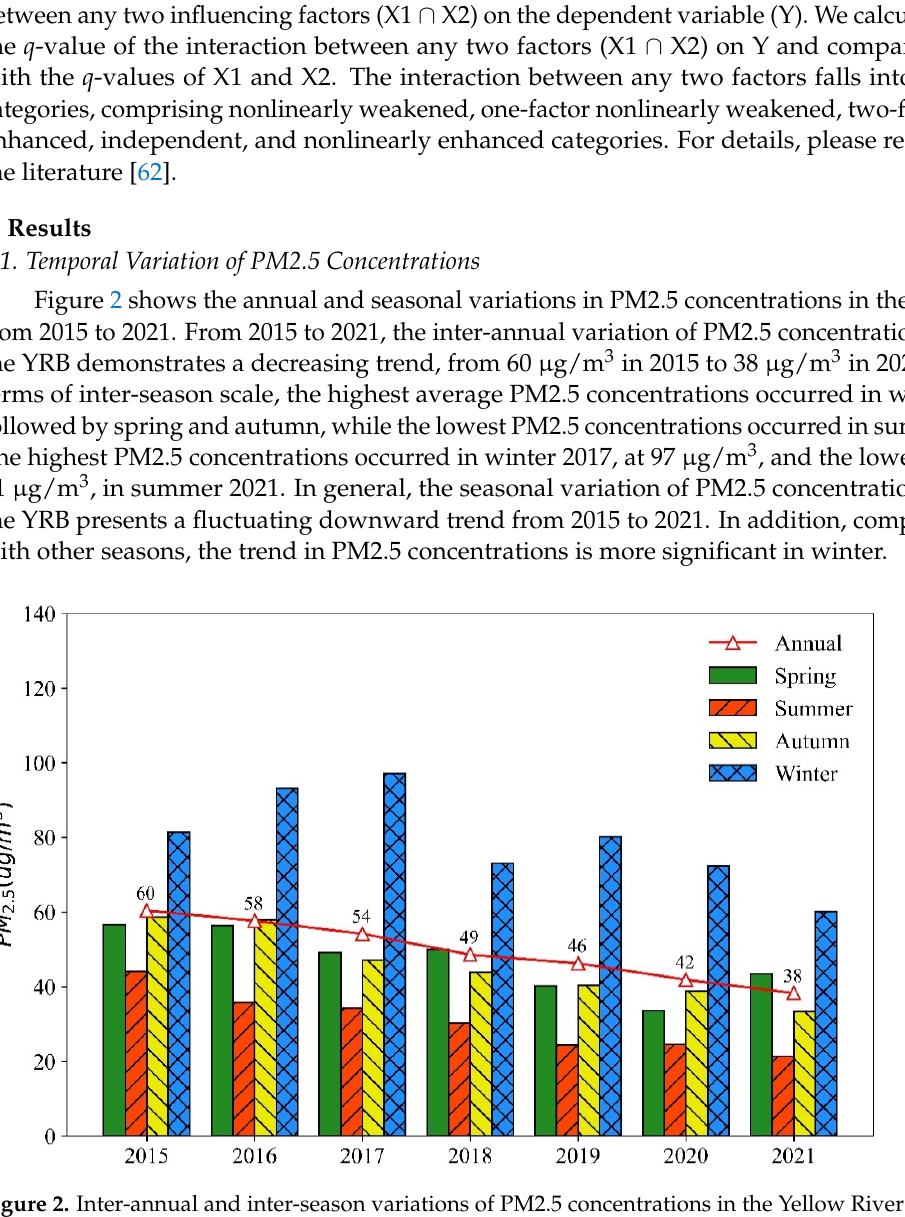
Figure 2. Inter-annual and inter-season variations of PM2.5 concentrations in the Yellow River Basin from 2015 to 2021.